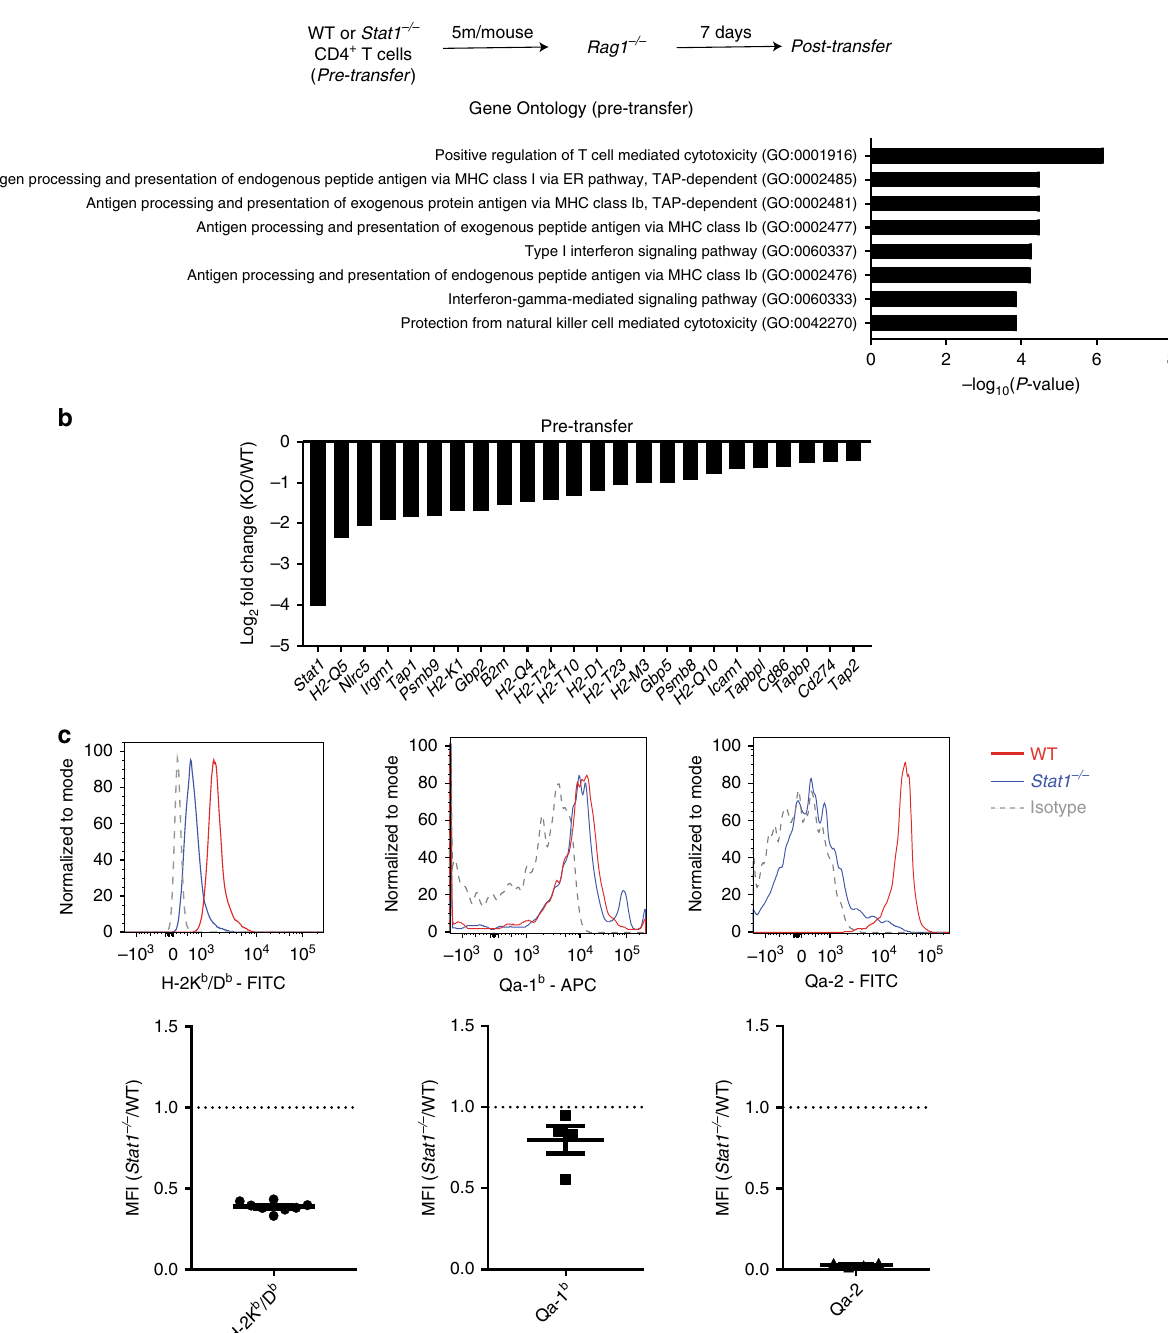
Fig. 5 Downregulation of the MHC class I antigen presentation machinery in Stat1 − / − T cells. RNA-seq was performed on WT or Stat1 − / − T cells pre- transfer. a Schematic of experimental setup and selected Gene ontology terms (PANTHER) showing differential expression of the MHC class I pathway in Stat1 − / − T cells. b Downregulation of various genes involved in MHC class I antigen presentation in Stat1 − / − T cells compared to WT T cells by RNA-seq. All genes displayed are signi fi cantly different between WT and Stat1 − / − T cells ( n = 3 biological replicates, p < 0.05 with correction for multiple testing by Benjamini-Hochberg procedure). Accompanied by Supplementary Fig. 2 where similar analyses were performed in T cells post transfer. c Representative fl ow cytometry plots showing surface expression of classical and non-classical MHC class I molecules on CD4 + T cells from the spleens of WT or Stat1 − / − mice, followed by their cumulative enumeration expressed as a ratio of Median Fluorescence Intensity ( Stat1 − / − / WT) ± SEM. Data is pooled from